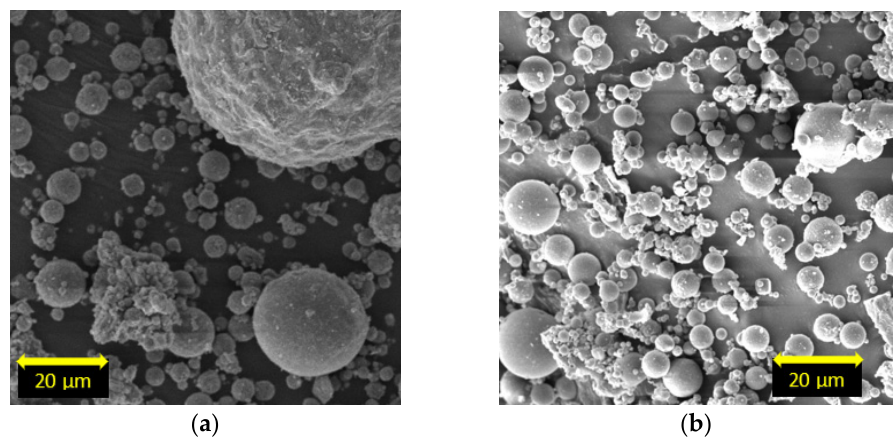
Figure 5. SEM images of ( a ) class C and ( b ) class F fly ash.